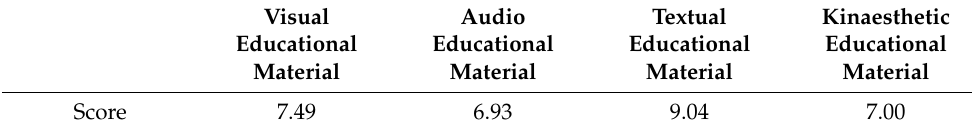
Table 2. Averages of knowledge test results by the form of learning materials presented. Visual